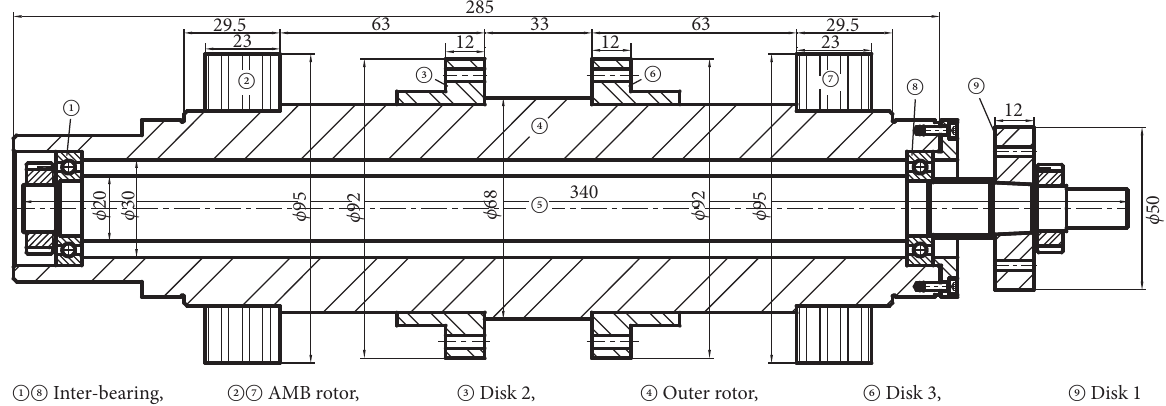
Figure 1: The MSDS structure. ①⑧ Interbearing. ②⑦ AMB rotor. ③ Disk 2. ④ Outer rotor. ⑤ Inner rotor. ⑥ Disk 3. ⑨ Disk 1.